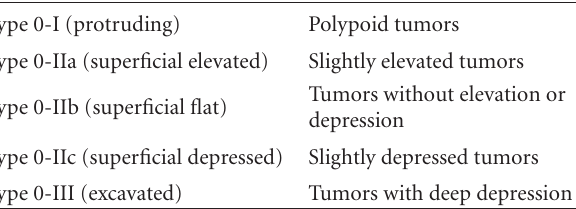
Table 1: Macroscopic classification of early gastric cancers